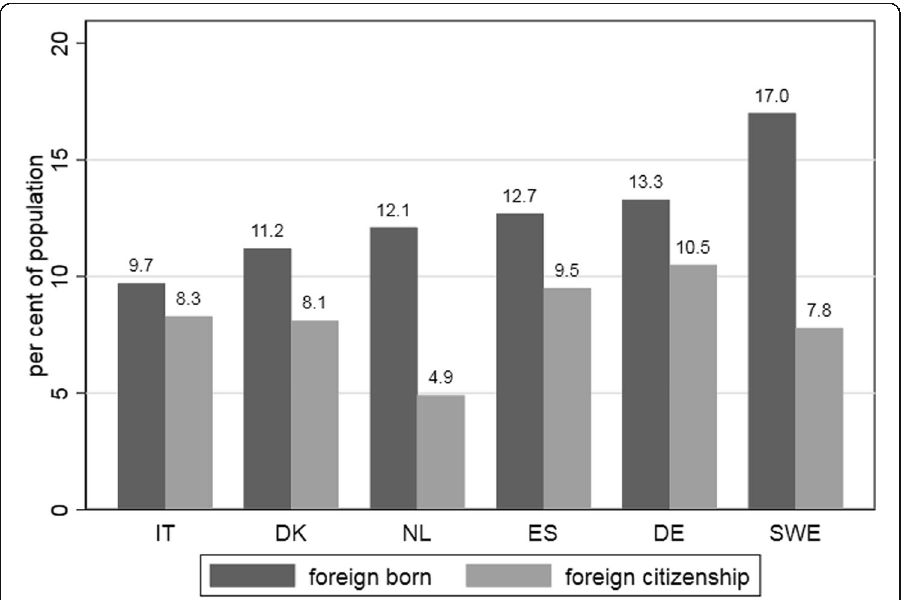
Fig. 4 Proportion of immigrants (1 January 2016, per cent of the population). Eurostat (online data code: